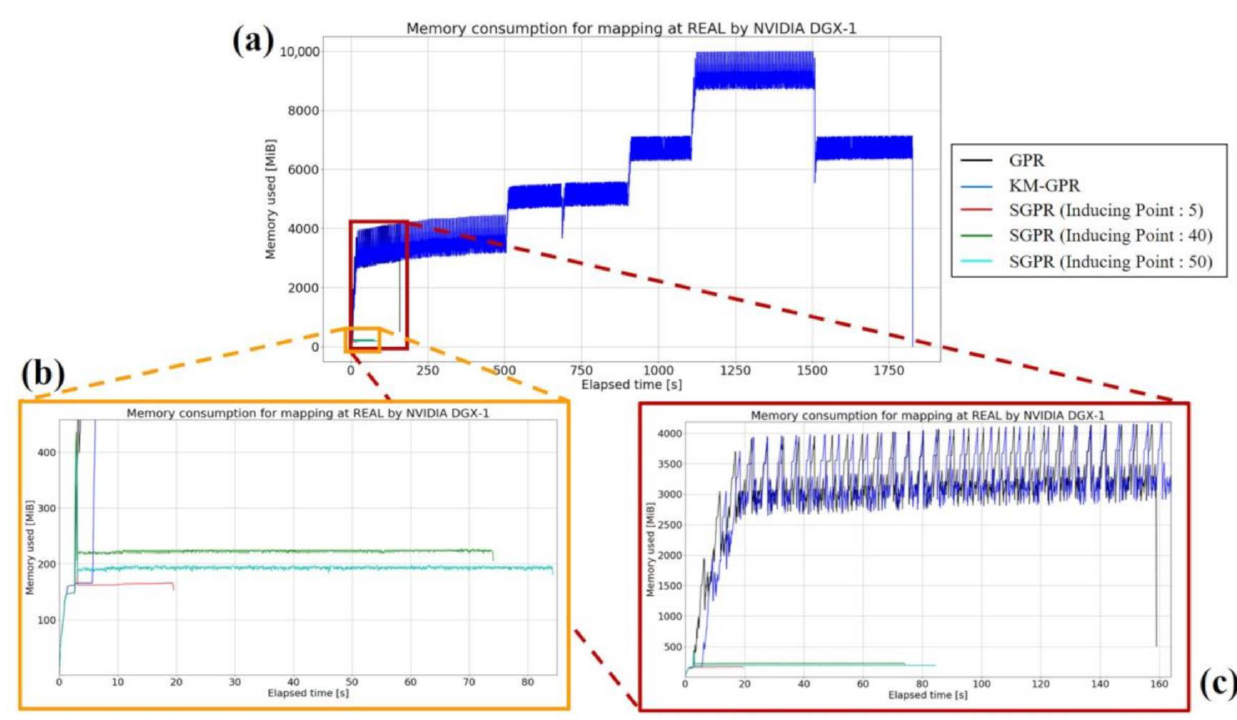
Figure 7. Graphs of memory consumption for each method in REAL’s magnetic mapping for GPR, KM-GPR, and SGPR with 5, 40, and 50 inducing points are shown. ( a ) Graph showing all methods, ( b ) enlarged graph of SGPR, and ( c ) enlarged graph of